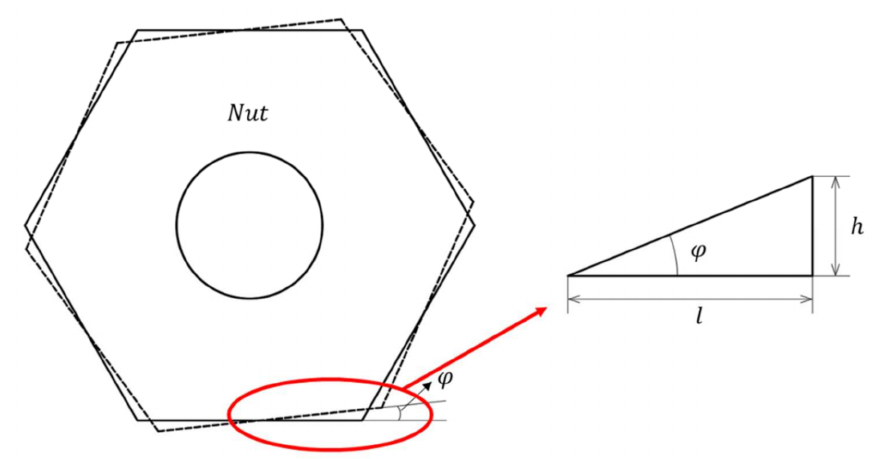
Figure 6. The method for measuring the rotation angle of the nut in the loosening direction.